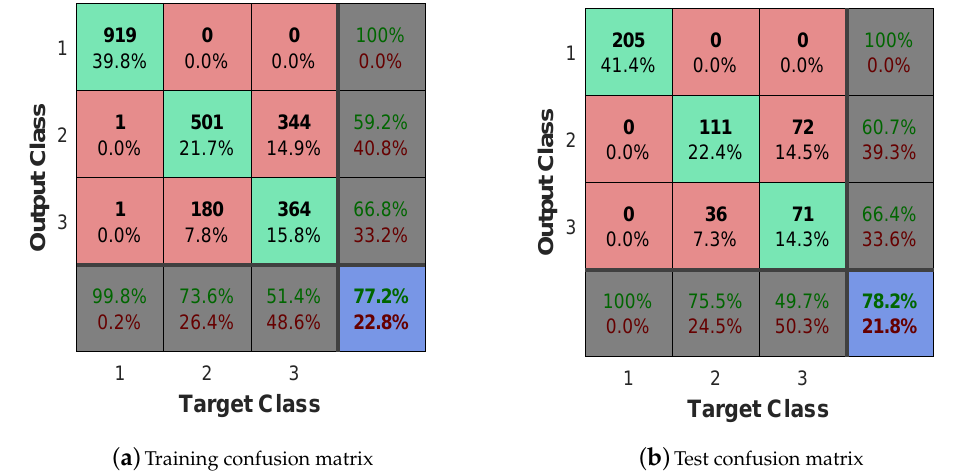
Figure 5. Confusion matrices for the training and test activity for the preliminary analysis.